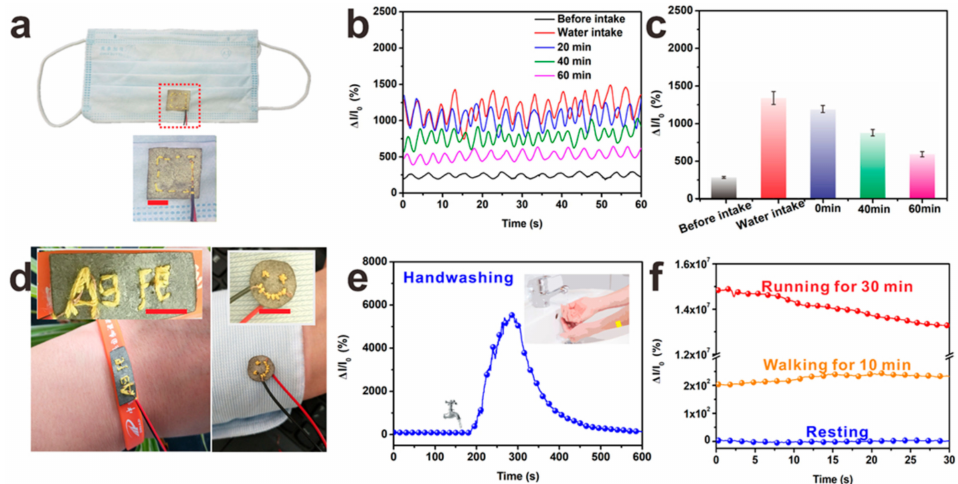
Figure 7. ( a ) Photograph showing the Ag@Fe 3 O 4 -MS fixed inside a common face mask. ( b ) Variation of the relative current through Ag@Fe 3 O 4 -MS in the breath before and after the volunteer drank water for a given time period afterwards. ( c ) Statistical results for the whole testing process of ( b ). ( d ) Tailoring and embroidery performances of Ag@Fe 3 O 4 -MS. ( e , f ) Performance in monitoring changes of humidity on the skin surface. Scale: 10 mm.